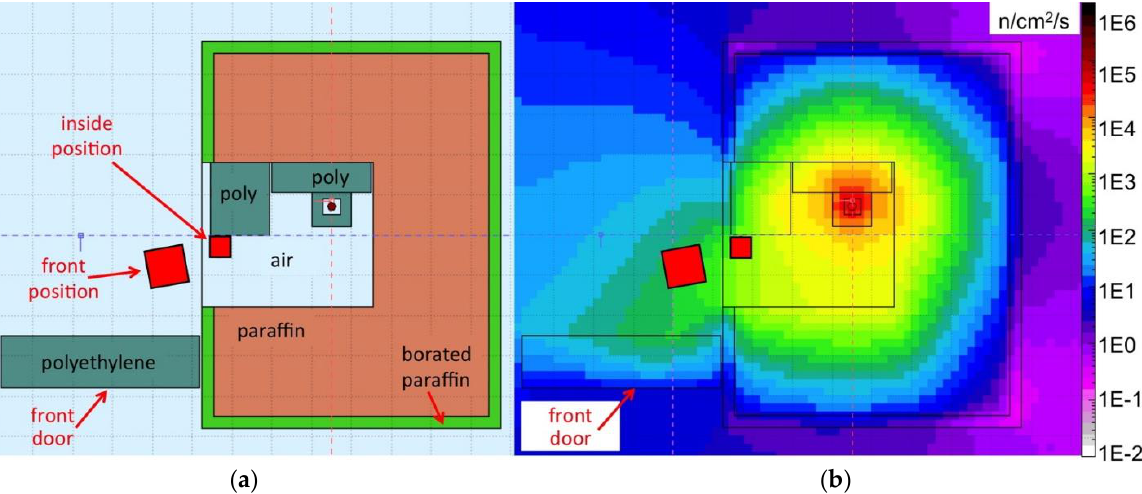
Figure 7. ( a ) Drawing of the top view of the section at 30 cm height of the neutron source box; the source position is indicated by a small dark circle, the red squares indicate the front and inside positions where the measurements were done; ( b ) the corresponding neutron flux obtained by means of a simulation with the Fluka code.